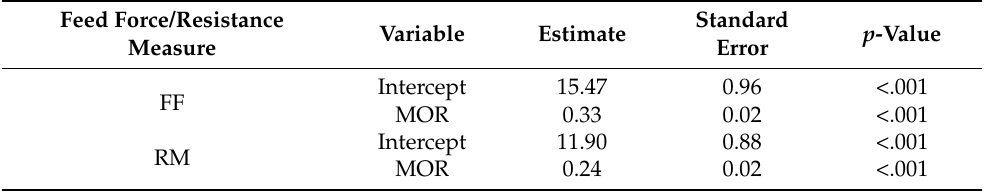
Table 13. Estimates for regression models of FF and RM with MOR as the predictor.